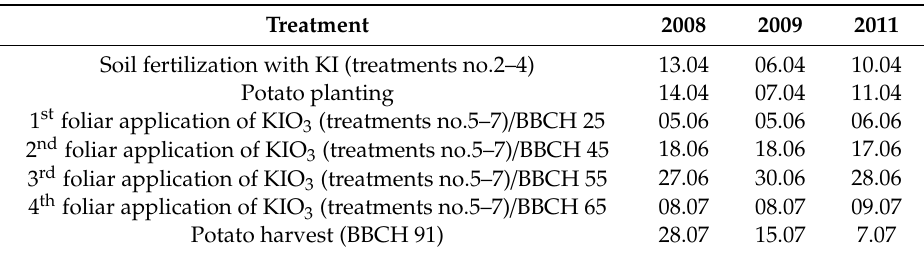
Table 2. Time schedule for the